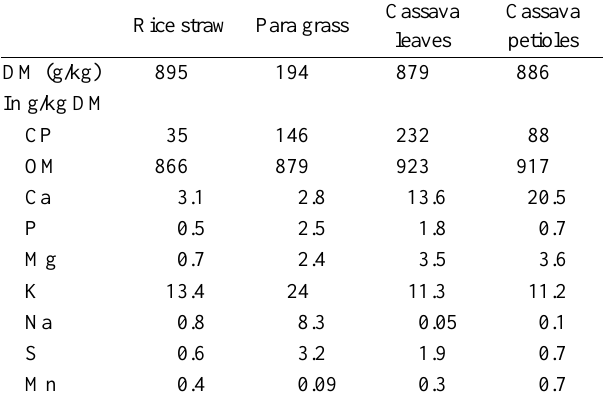
Table 1. Chemical composition of feeds used in the